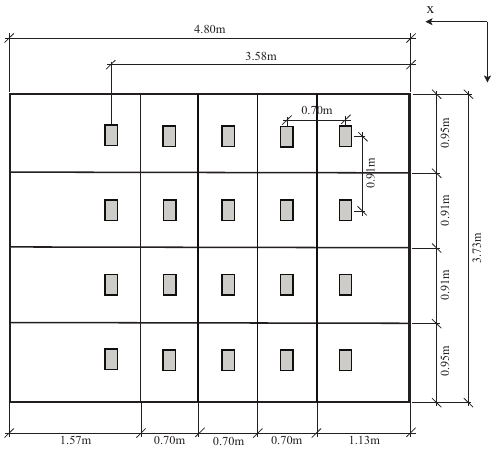
Figure 6. Positions of the mid-to-high frequency range